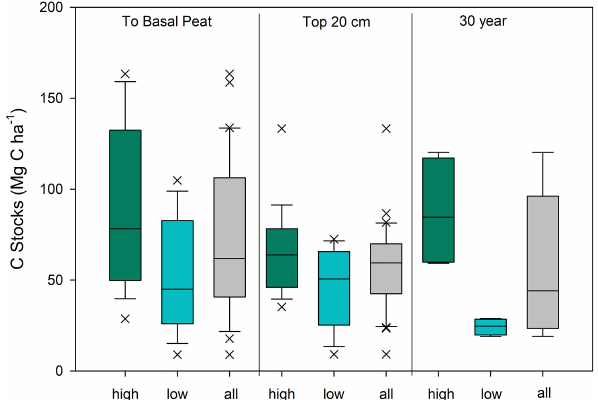
Figure 4. Carbon stock estimates for Clayoquot Sound for the high marsh zone (green), low marsh zone (blue), and combined (grey) for all cores. Estimates are made to the base of the peat layer, for the surface 20cm, and for the most recent 30 years of accretion. Note that 30-year values are based on four cores each for high and low marshes (see Methods). Unpaired t tests show statistically sig- nificant differences between the high and low marsh C stocks calcu- lated to the base of peat depth ( t = 2 . 91, p value = 0.0065), 20cmC stocks ( t = 2 . 20, p value = 0.036) and 30yearC stocks ( t = 3 . 95, p value =